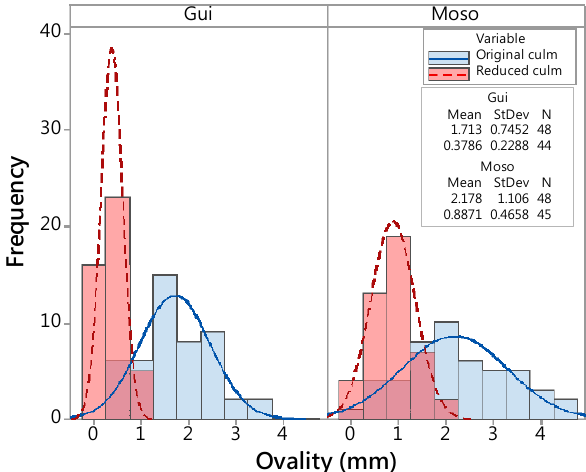
Figure 8. The histograms of ovality before and after the reduction of the samples.